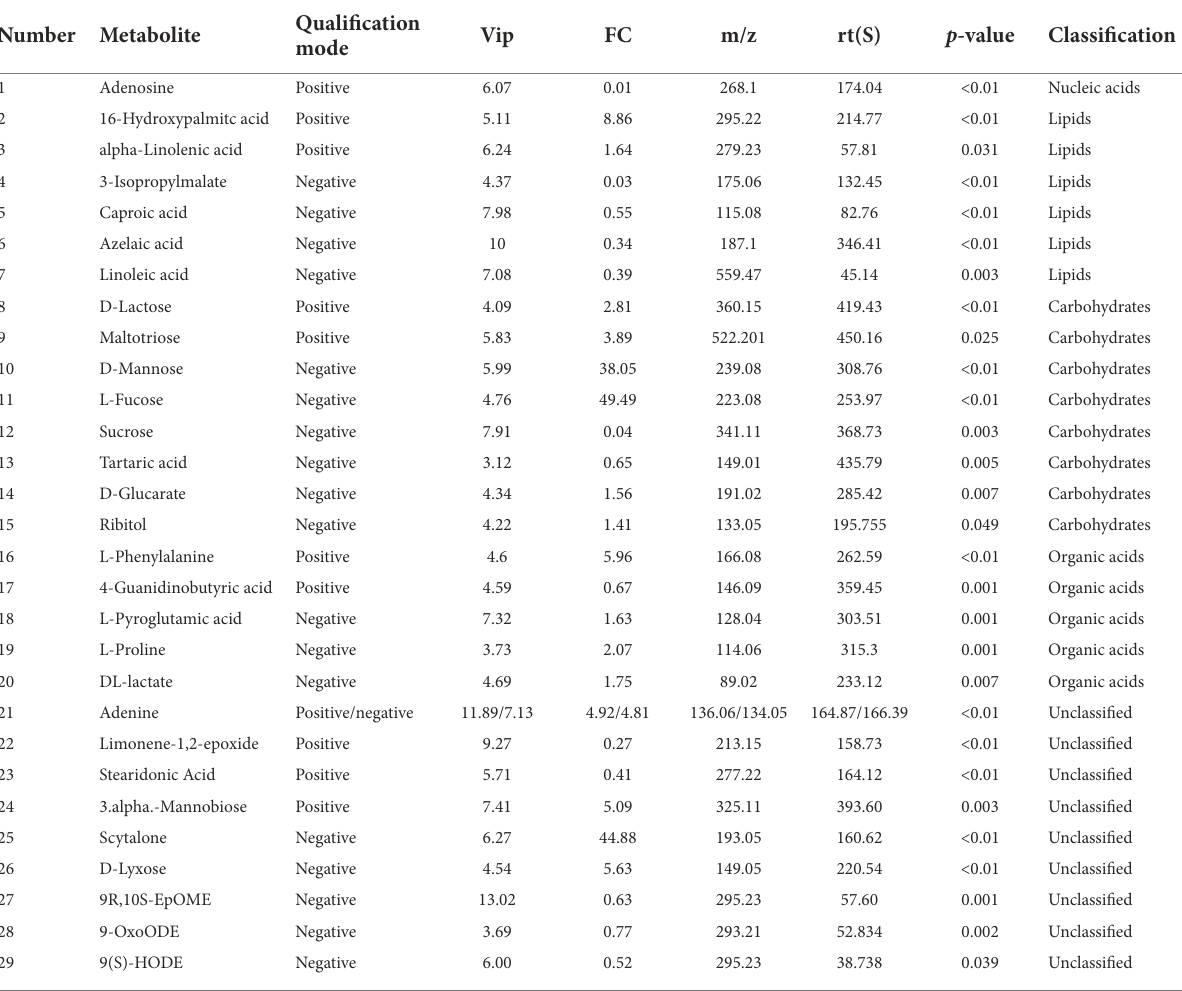
TABLE 3 Main difference metabolites between FGSM group and CON group.